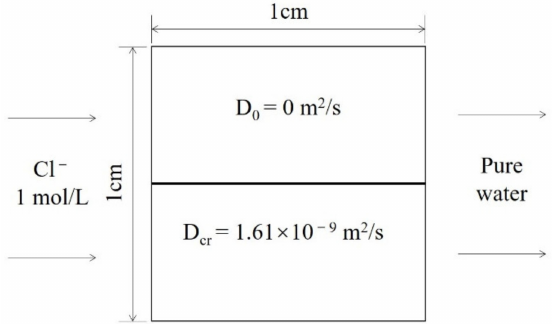
Figure 1. Illustration of the simulated steady-state diffusion in cracked